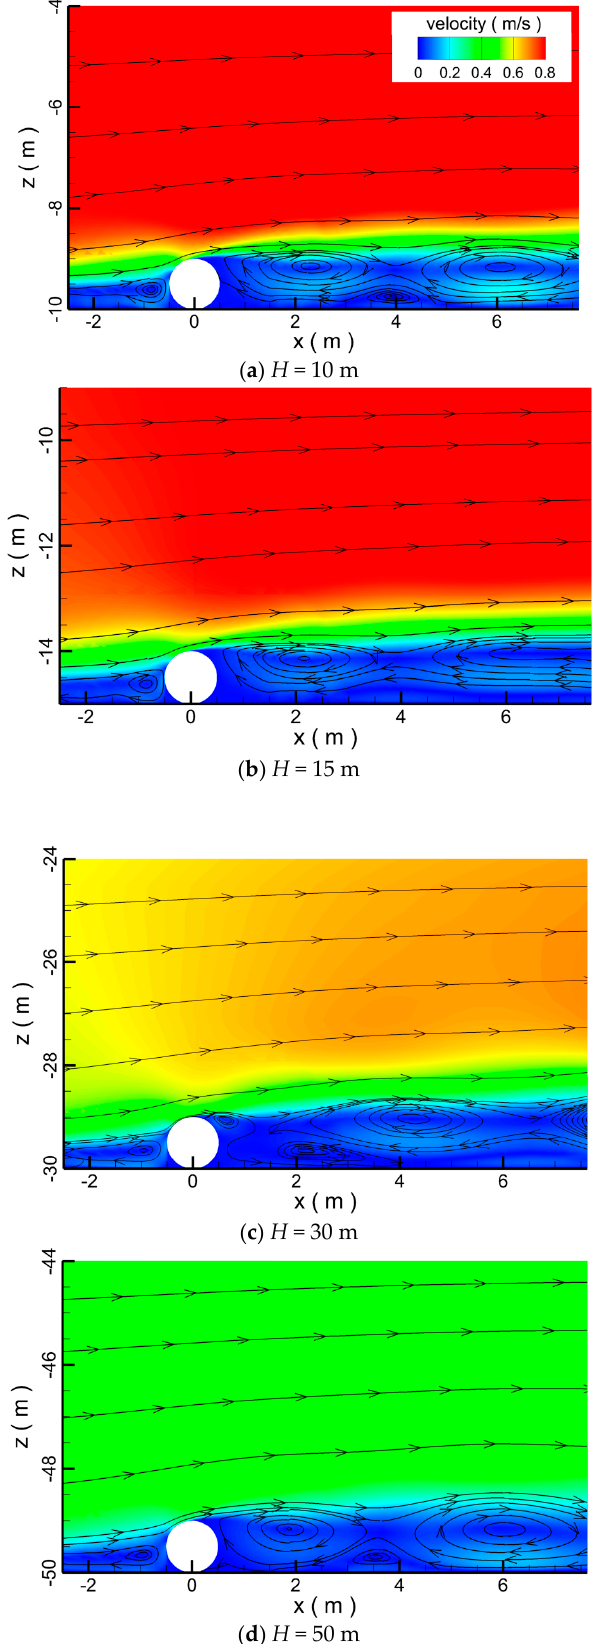
Figure 19. The flow fields around the pipeline in different water depths in the time of t = 39 h.